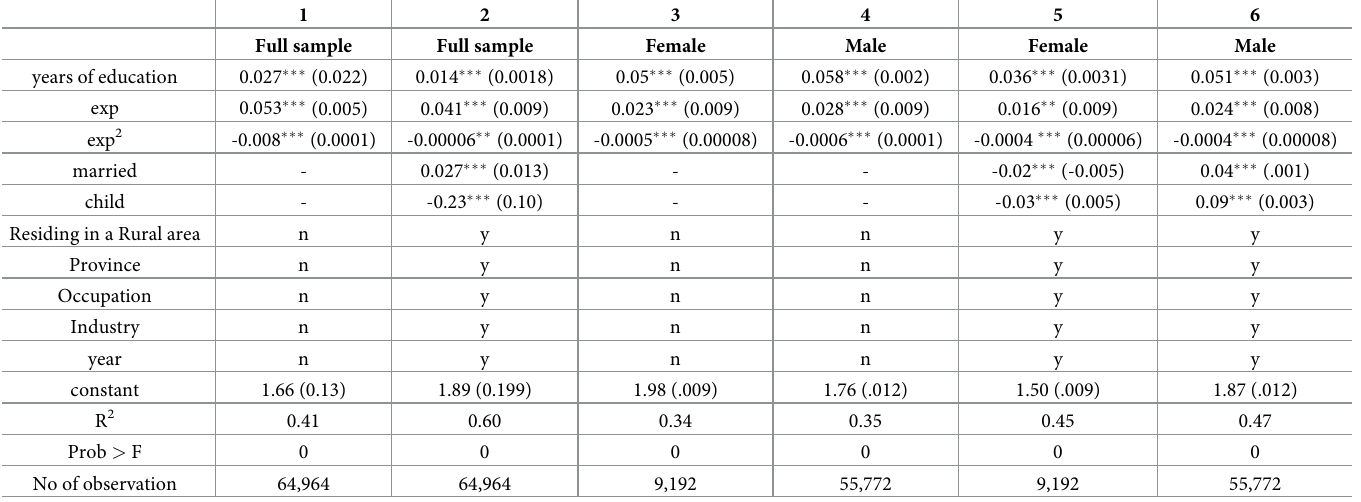
Table 5. Return to education by the attained level